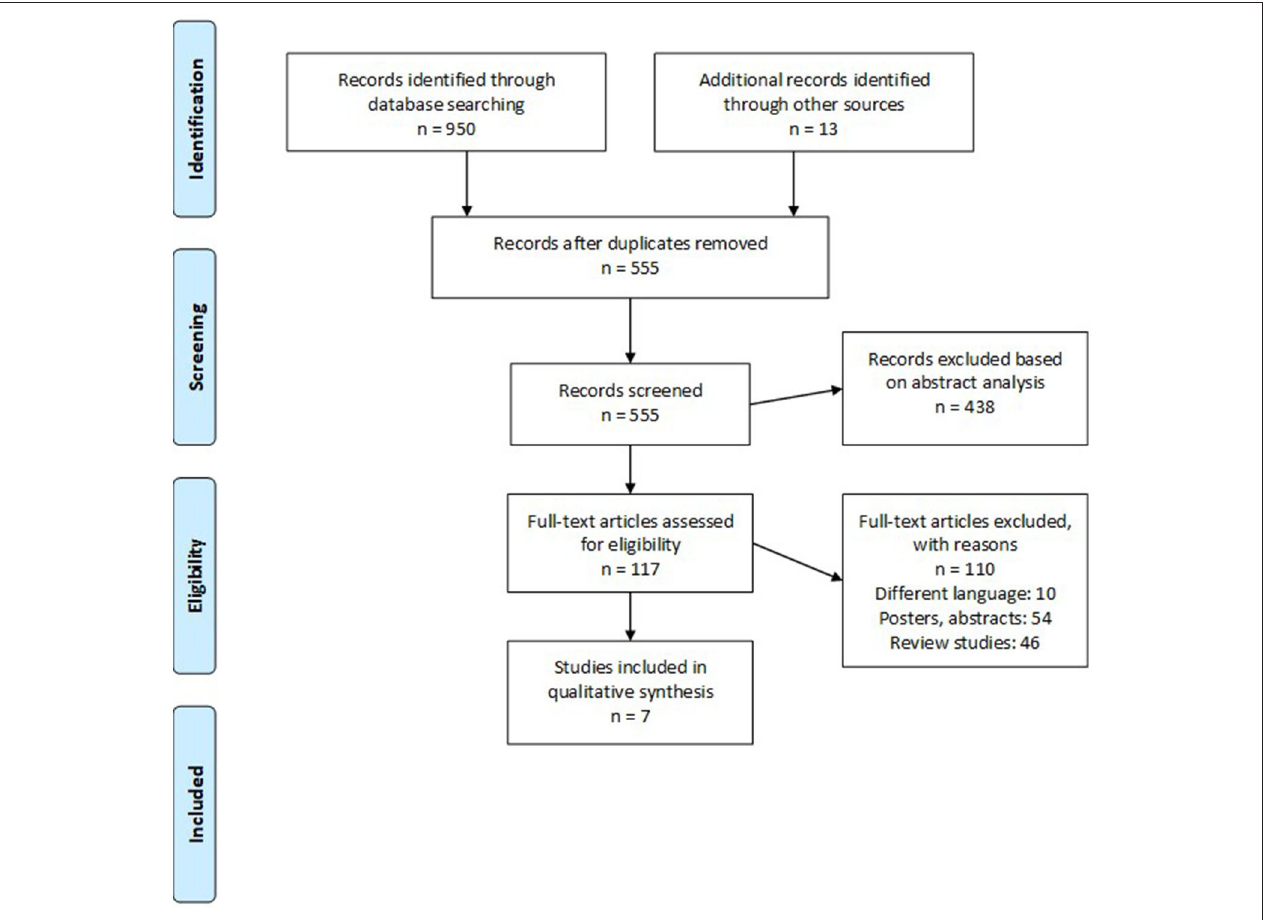
FIGURE 1 | PRISMA